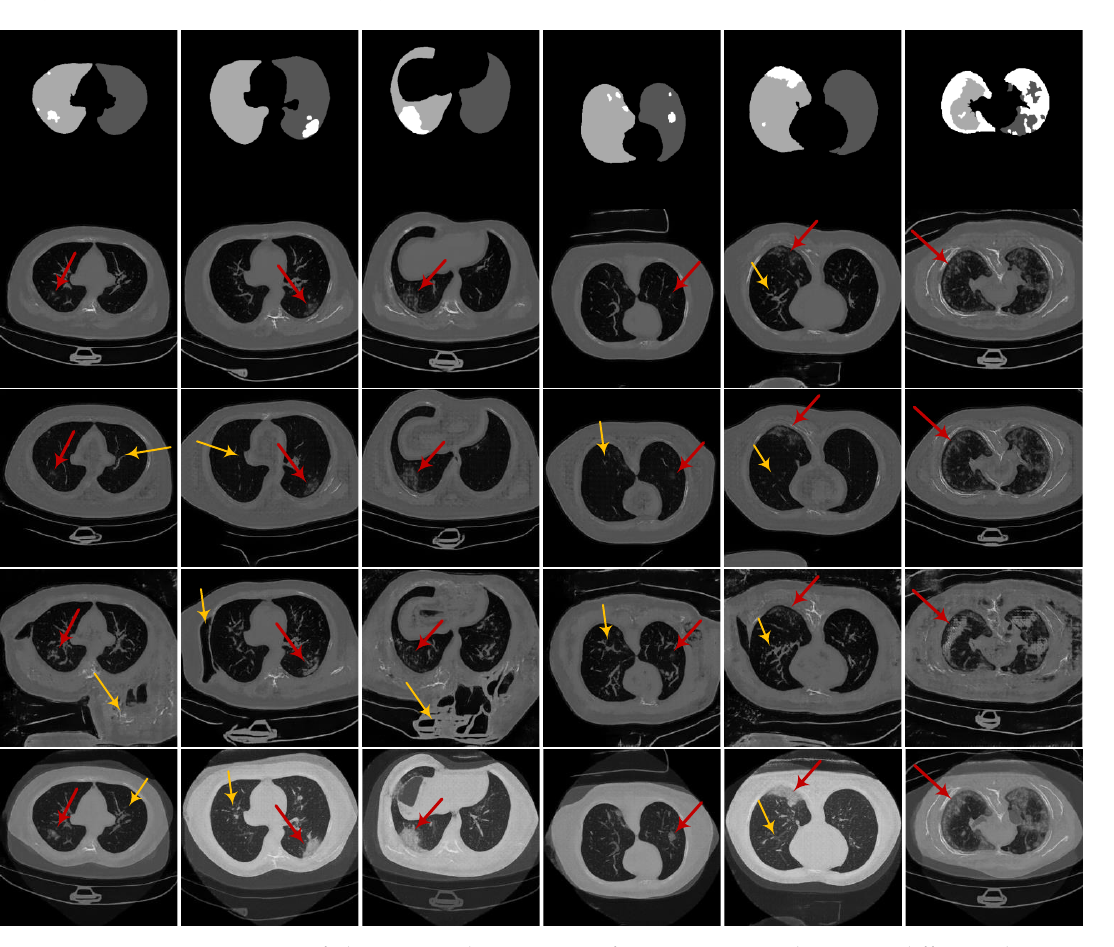
Figure 12. Comparison of diverse synthetic images from CoSinGAN by using different data diversification methods. The rows from top to bottom represent input conditions, synthetic images without using any data diversification methods, results of applying dropout at test time, results of randomizing input condition, and results of fusing synthetic images from two different CoSinGANs, respectively. Red and yellow arrows highlight the differences of synthetic images. The white and gray (e.g., light gray and dark gray) in condition masks represent the infected regions and lungs,